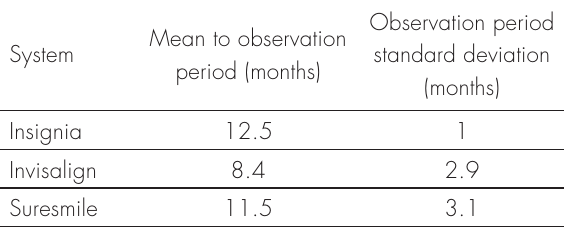
Table VI. Mean and SD of observation period in months for each intervention.